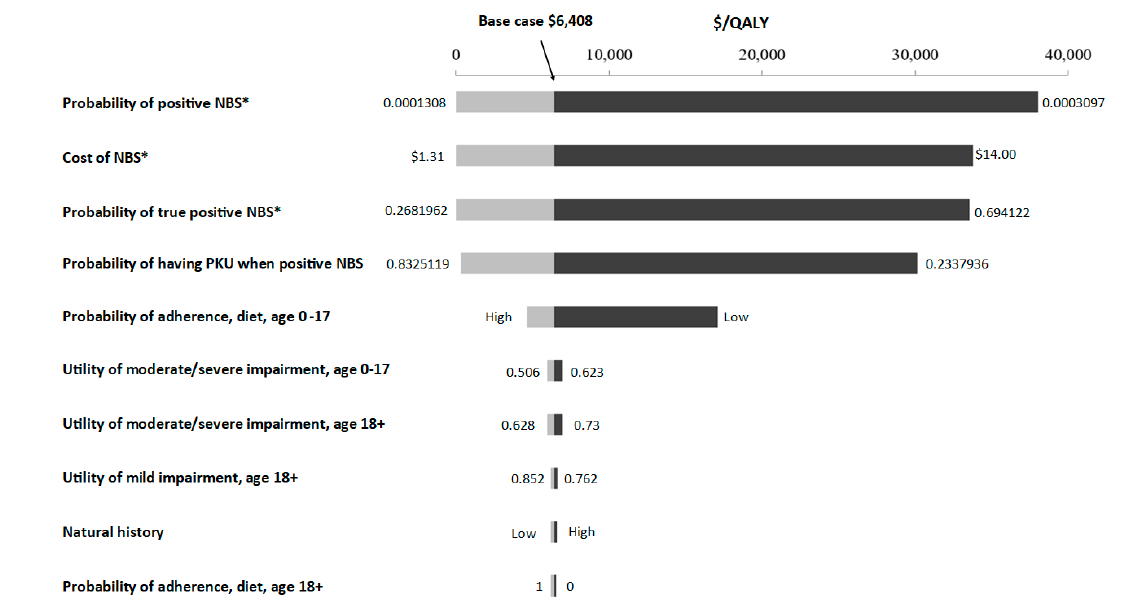
Figure 3. One-way sensitivity analysis for NBS/diet when compared with CI/diet, ICER. * For these variables, when the value decreased to a certain threshold, the reference case switched to NBS/diet and becomes a cost-saving strategy when compared to CI/diet the ICER is negative with NBS/diet as reference case, therefore, 0 is used here to indicate that NBS/diet is the more cost-effective strategy when the value is lower, i.e., when the cost of NBS decreases, when the probability of NBS screened positive decreases, and when the probability of true positive decreases, all these would turn NBS/diet to a more favorable